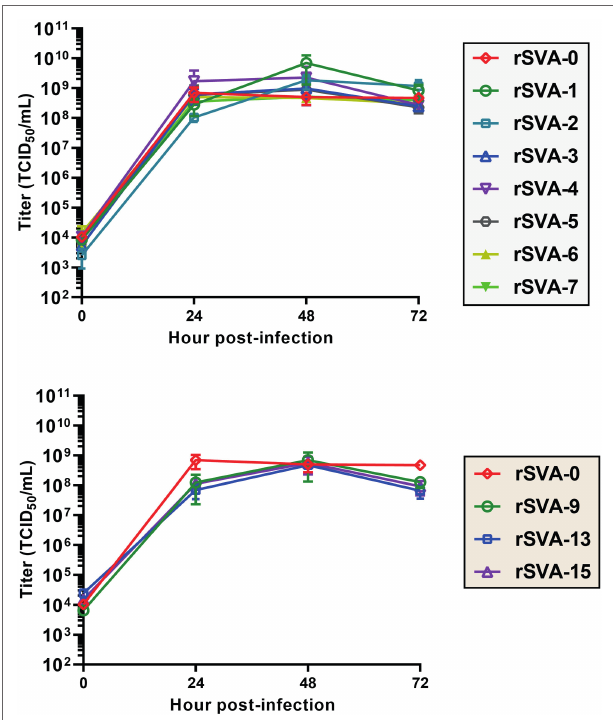
FIGURE 6 | Multistep growth curves of replication-competent rSVAs at P6. Viral titers are measured using the Spearman–Kärber equation. Data at 0, 24, 48, and 72 hpi are representative of three independent experiments. Error bar indicates standard